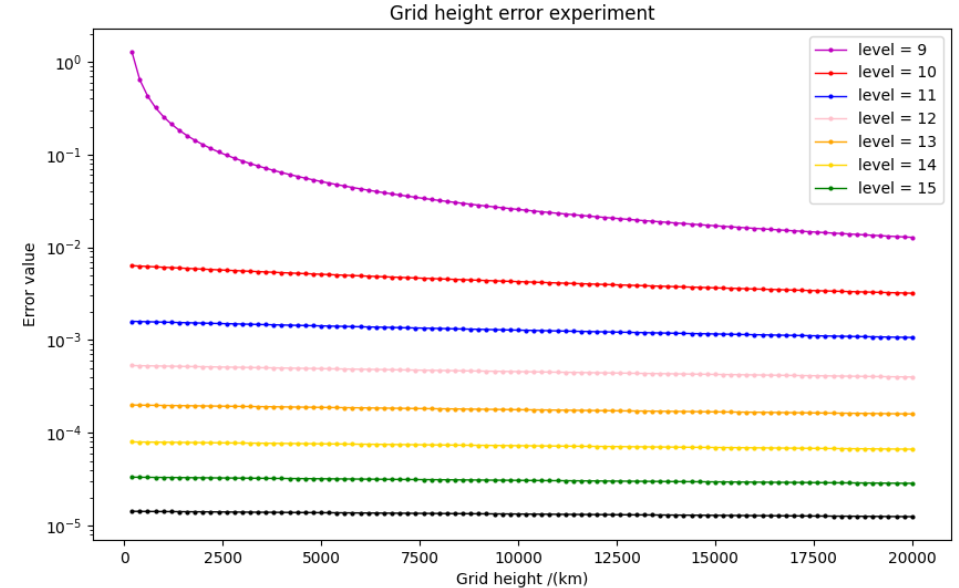
Figure 10. Effect of height on the accuracy of grid calculation under 9–15 levels.